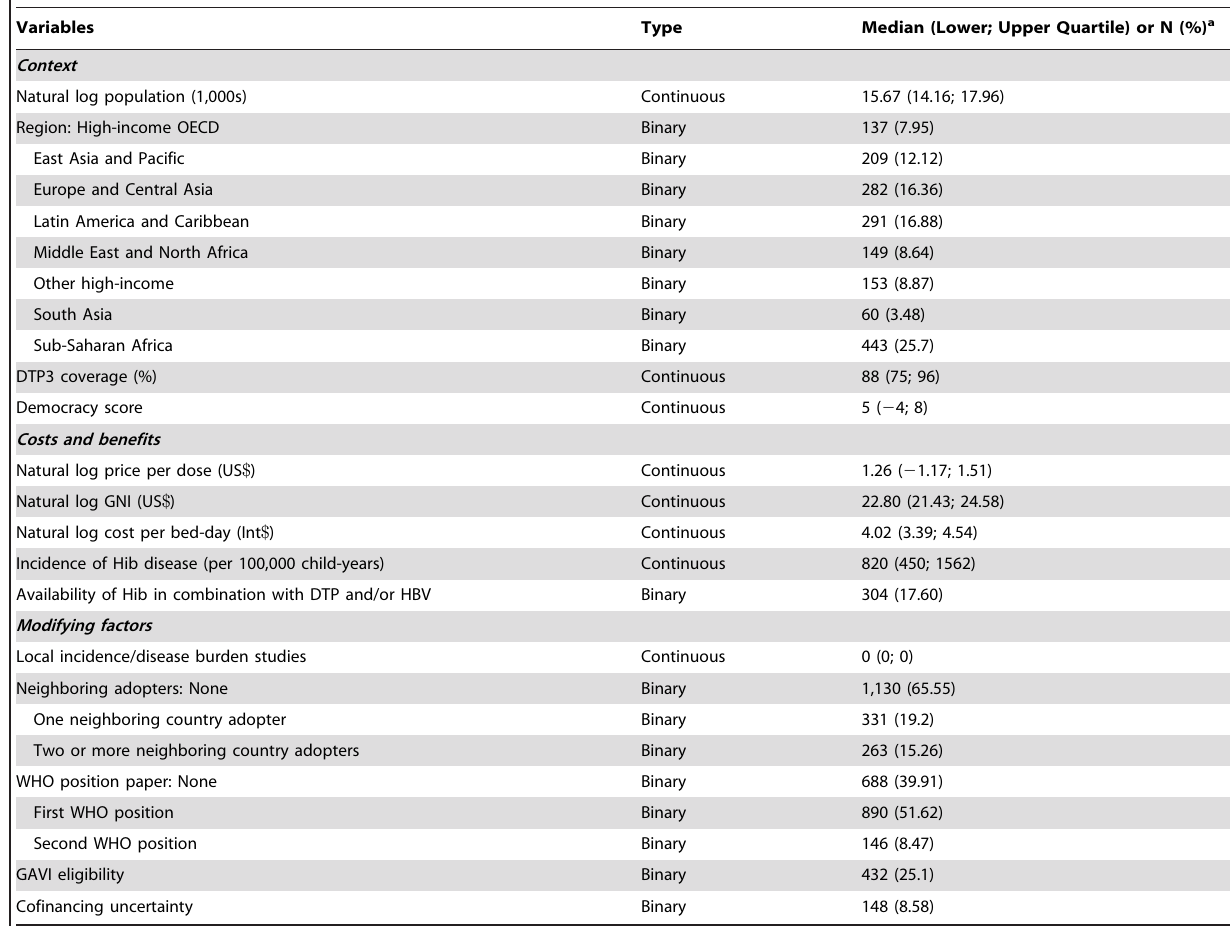
Table 2. Summary statistics of included independent